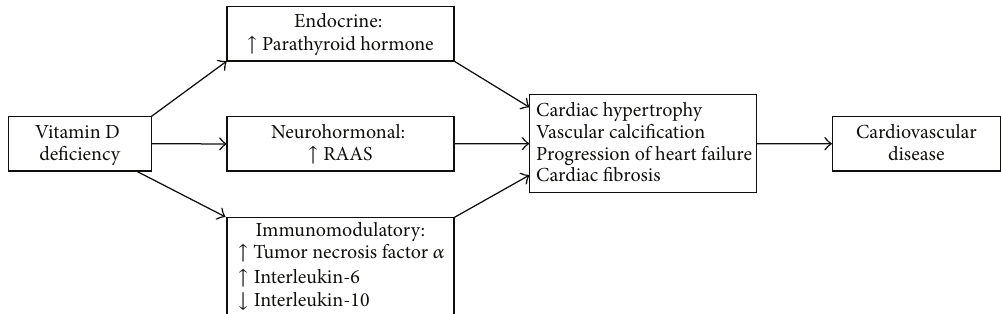
Figure 3: Cardiovascular pathophysiology of vitamin D